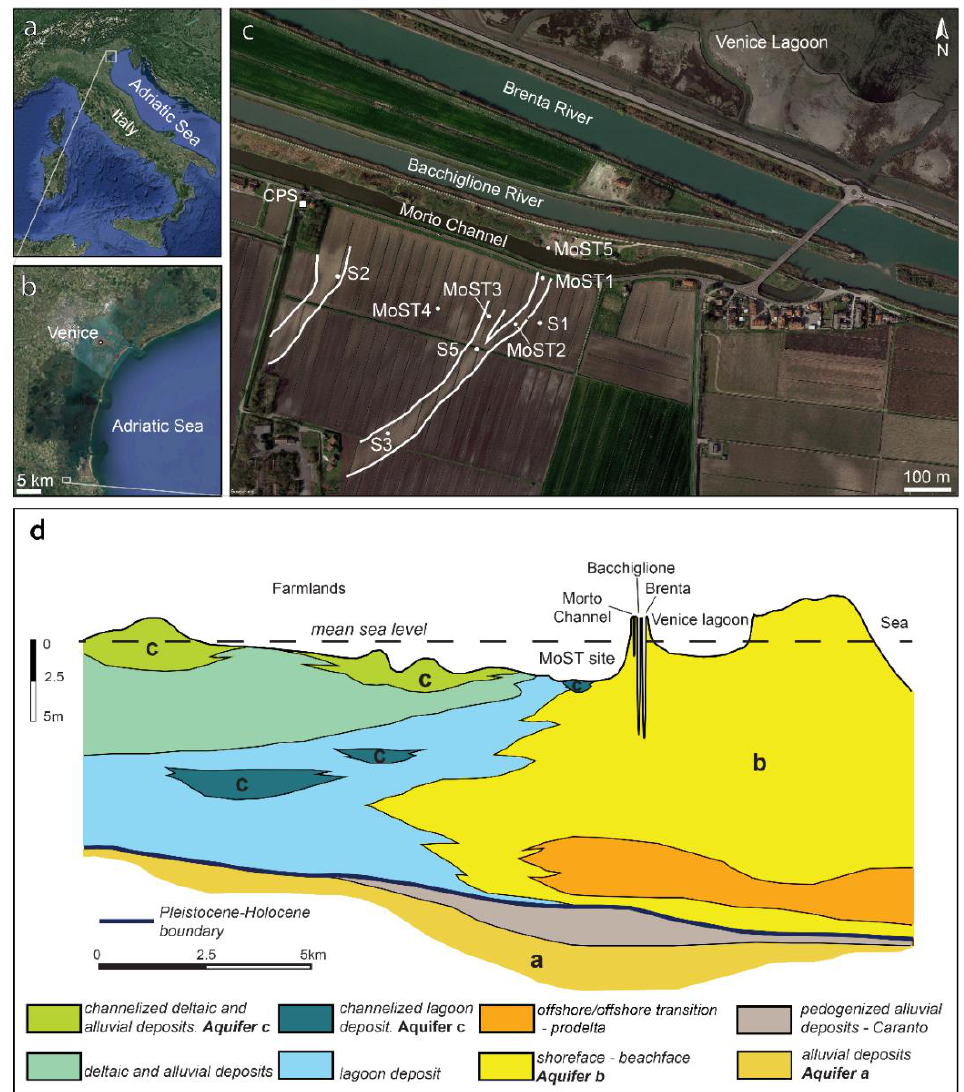
Figure 1. ( a ) Location of the study area along the coast of the Northern Adriatic Sea, Italy; ( b ) location of the study area at the southern margin of the Venice lagoon; ( c ) map of the Study area. Dots indicate the position of piezometric wells and cores (S1, S2, S3, S5, MoST1, MoST2, MoST3, MoST4, MoST5). White lines delineate boundaries of surficial sand bodies. CPS indicates the position of the Casetta Pumping Station. Base map source: Esri, Maxar, Earthstar Geographics, USDA FSA, USGS, Aerogrid, IGN, IGP and the GIS User Community; ( d ) stratigraphic setting of the Upper Pleistocene and Holocene succession at the southern margin of the Venice lagoon. Modified From [34].